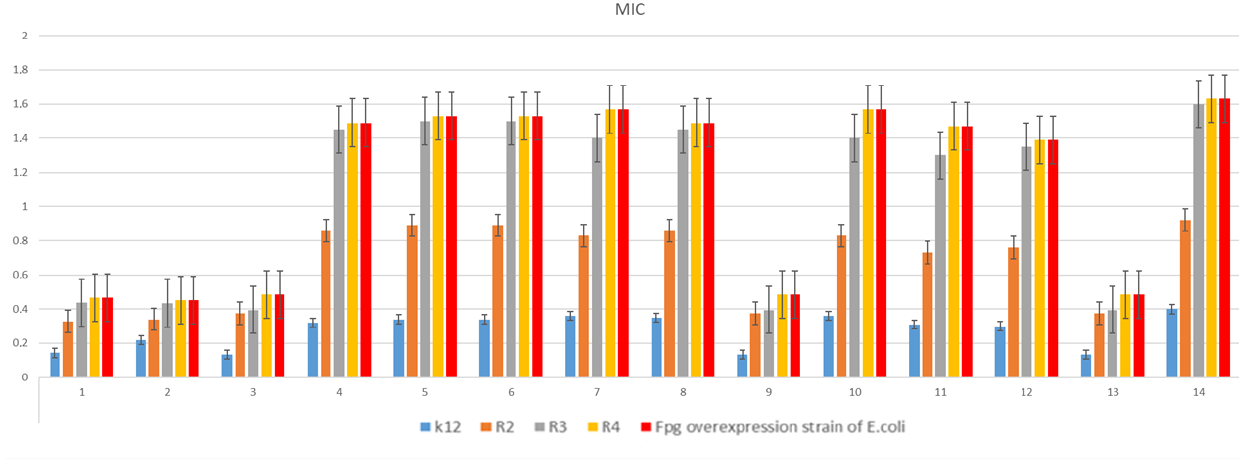
Figure 4. Minimum inhibitory concentration (MIC) of the coumarin derivatives 1 – 14 in the model bacterial strains. The x -axis features compounds 1 – 14 . The y -axis shows the MIC value in µg/mL. Investigated strains of E. coli K12 as control (blue), R2 strains (orange), R3 strain (grey), and R4 strain (yellow), Fpg overexpression strain (red bars). The order in which the compounds were applied to the plate are shown in Supplementary Materials Figure S1.